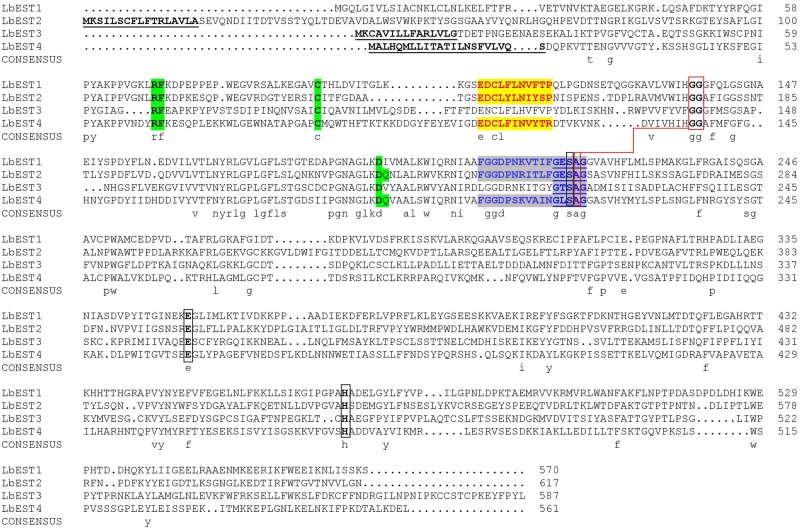
Alignment of the deduced amino acid sequence of four Liposcelis bostrychophila esterase genes. The signal peptide is underlined with a solid line in bold letters; the conserved motifs are in green shadow; the catalytic triads are marked with black box; the residues for the oxyanion hole are linked with red box; the esterase conserved motif, GxSxG, is marked with blue letters and underlined with a blue solid line; The type-B carboxylesterase signature 2 motif and serine motif are highlighted in yellow (red letters) and gray (blue letters), respectively.